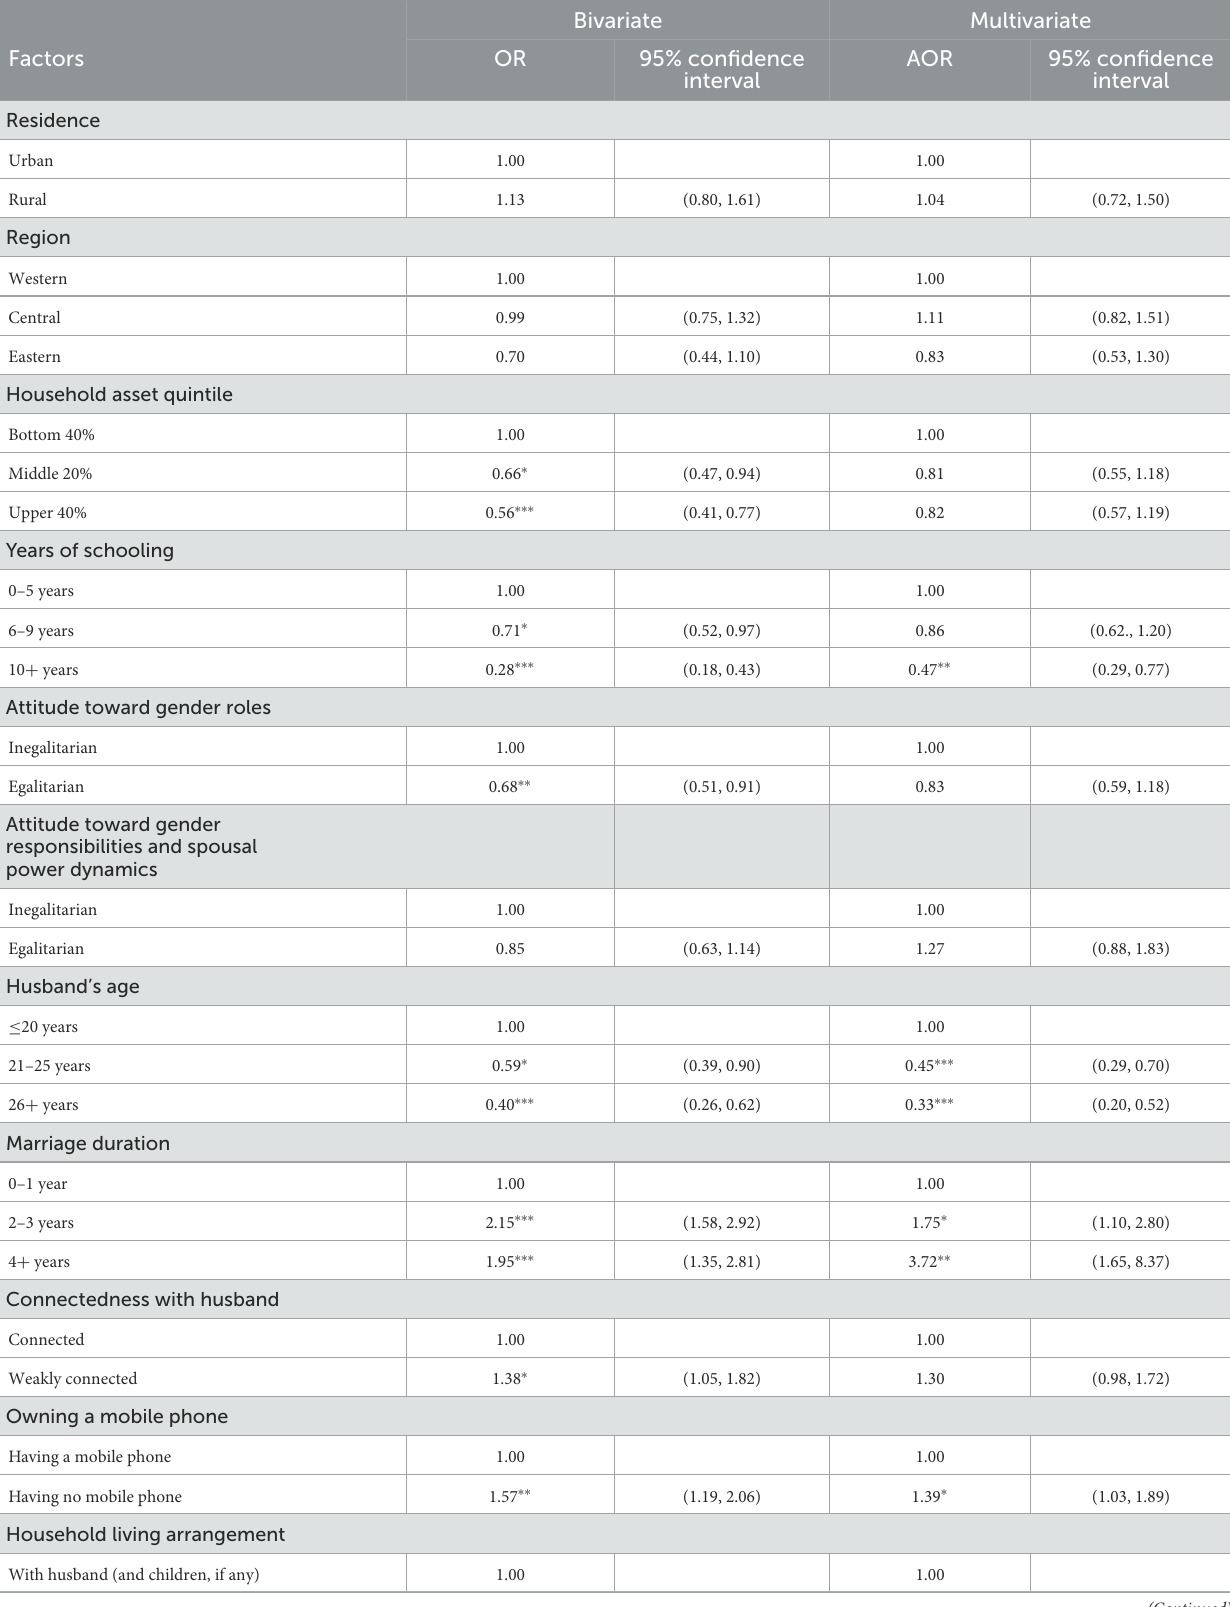
TABLE 3 Binary logistic regression-based unadjusted odds ratios (OR) and adjusted odds ratios (AOR) of IPPV among currently married adolescents ages 15–19, Bangladesh Adolescents Health and Wellbeing Survey 2019–20. Bivariate